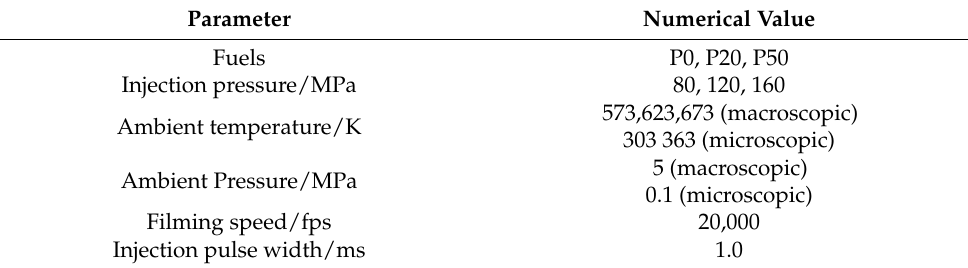
Table 2. Experimental parameters used in the current work.